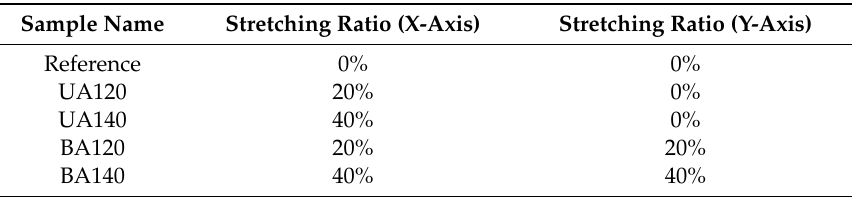
Table 1. Stretching ratios of Ag films.